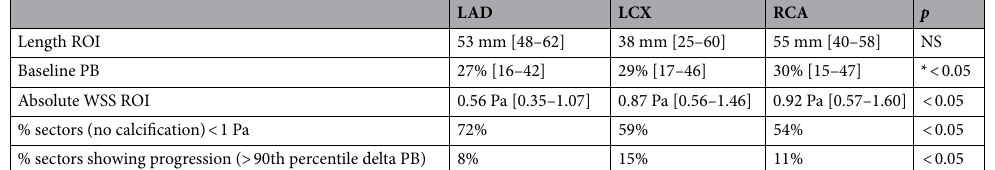
Table 2. Vessel characteristics. ROI region of Interest, PB plaque burden, WSS wall shear stress, LAD left anterior descending, LCX left coronary circumflex, RCA right coronary artery. *Only significant for LAD versus LCX and LAD versus